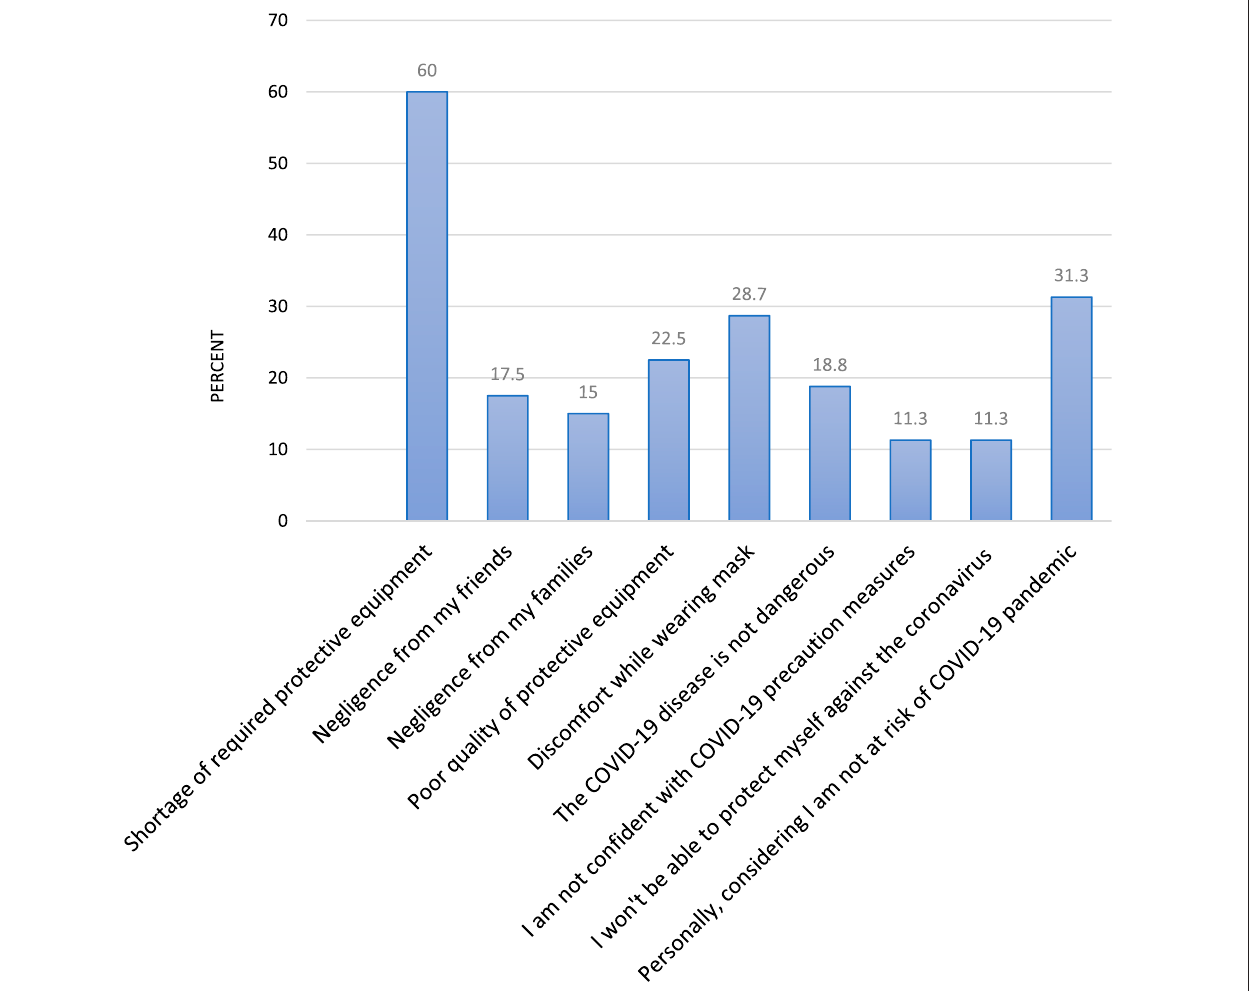
FIGURE 1 | Destributions of reasons why not intend to carry COVID-19 WHO prevention measures among Debre Berhan University students, Northeast Ethiopia, 2021.